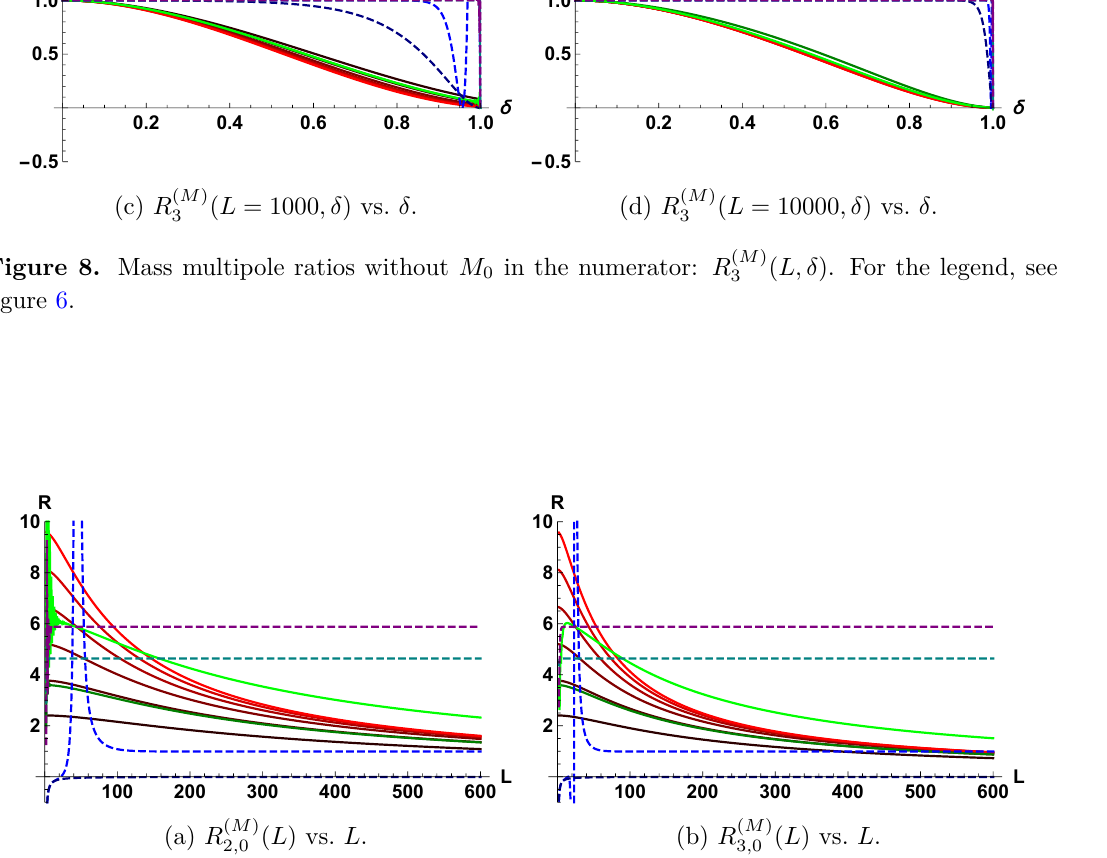
( L ) . For the legend, see figure i, 0